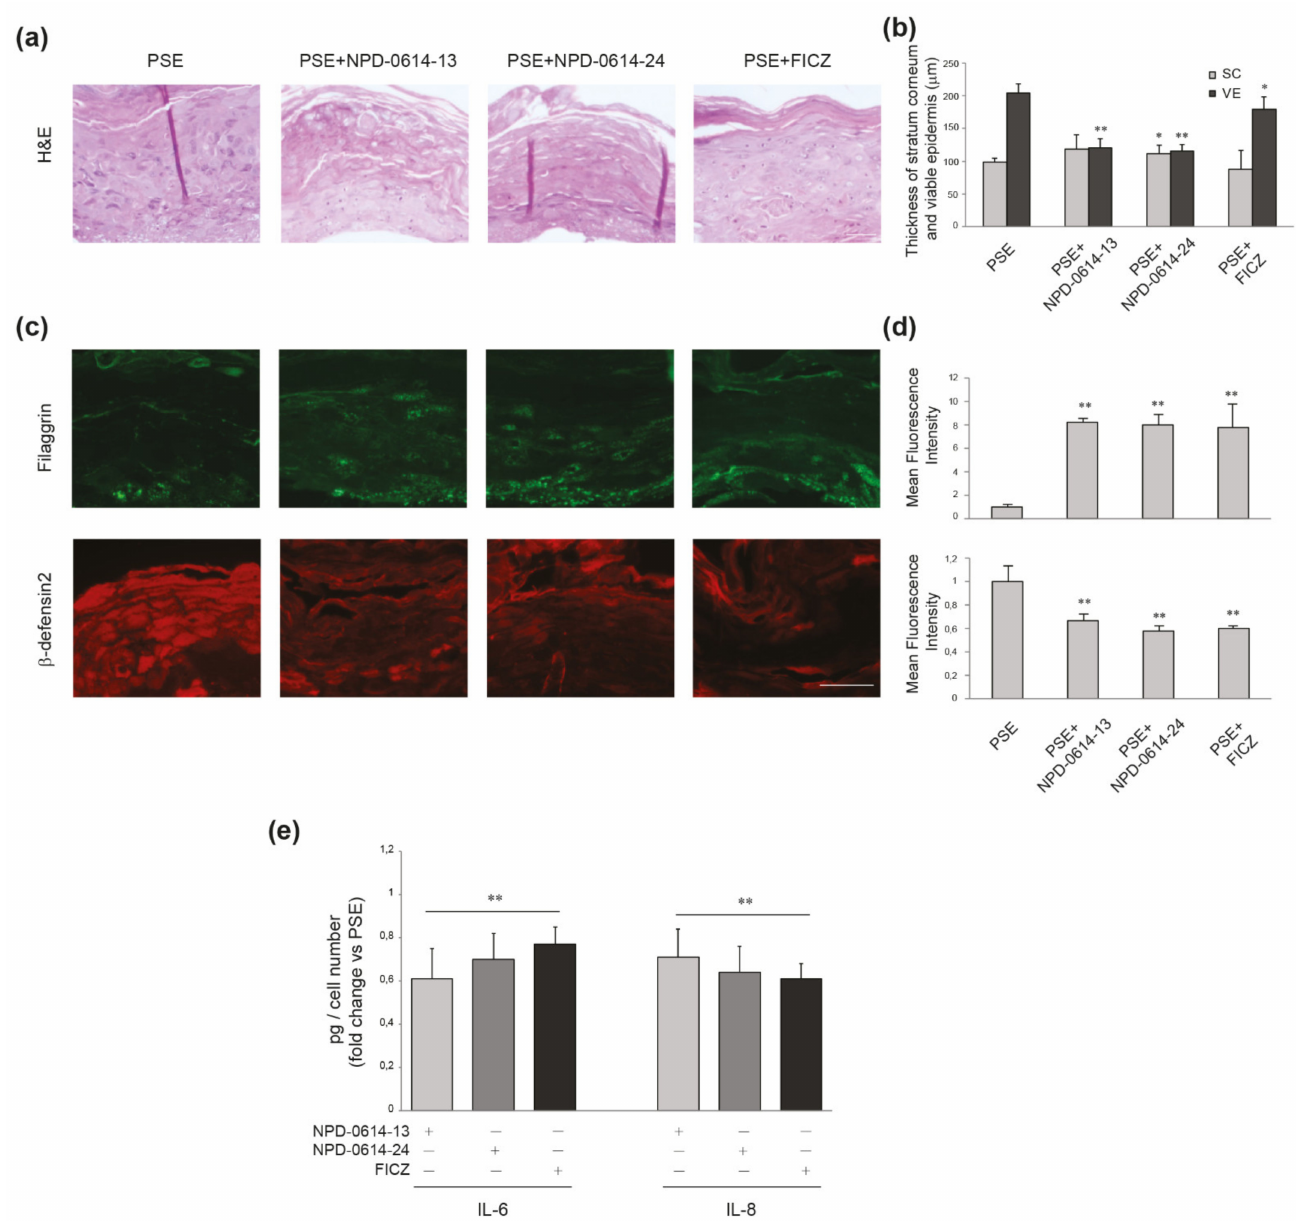
Figure 8. Effects of NPD-0614-13 and NPD-0614-24 on psoriasis skin equivalents (PSEs). ( a ) Hematoxilin–eosin staining of PSEs cultured in the presence or absence of NPD-0614-13, NPD-0614-24 (25 µ M) and FICZ (100 nM) for 4 days. Bar: 50 µ m. ( b ) Morphometric analysis of stratum corneum (SC) and viable epidermal layers (VE). The thickness of SC and VE was expressed as mean value ± SD (* p < 0.05, ** p < 0.01 vs. PSEs). ( c ) Representative immunofluorescence images after using antibodies against filaggrin and beta-defensin-2. Nuclei were counterstained with DAPI. Bar: 50 µ m. ( d ) Quantitative analysis of fluorescence intensity was expressed as mean value ± SD (** p < 0.01 vs. PSEs). ( e ) IL-6 and IL-8 quantitation by ELISA in PSEs in the presence of absence of NPD-0614-13, NPD-0614-24 (25 µ M) or FICZ (100 nM) for 72 h. The data are expressed as mean ± SD (** p < 0.01 vs.